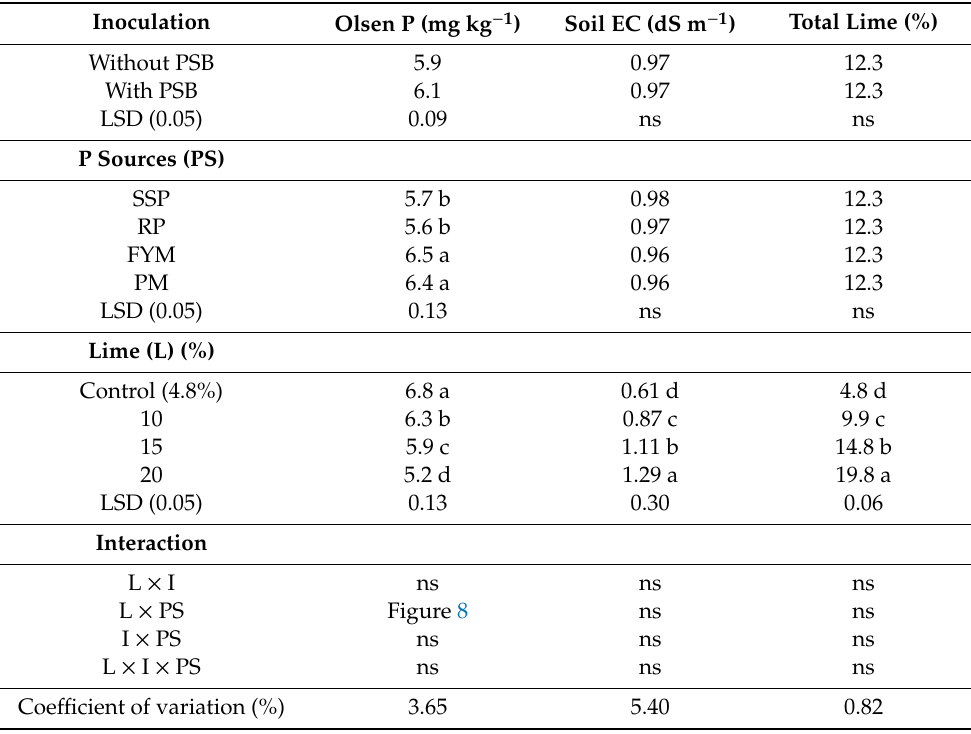
Table 6. Postharvest soil Olsen P, electrical conductivity (EC) and lime content as a ff ected by phosphate-solubilizing bacteria (PSB), phosphorus sources under varying